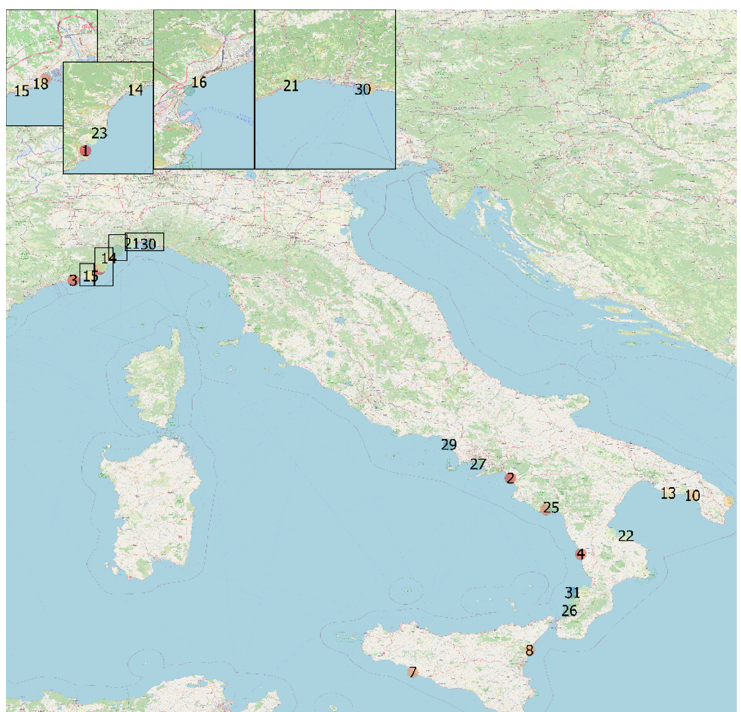
Figure 1. Stranding sites of cetaceans infected by dolphin morbillivirus, Italy, 2018–2020. Geographical mapping was created by M.I.C. with QGIS 3 software (QGIS Geographic Information System, QGIS association. www.QGIS.org, accessed on 29 January 2022) using the geographical coordinates found from the